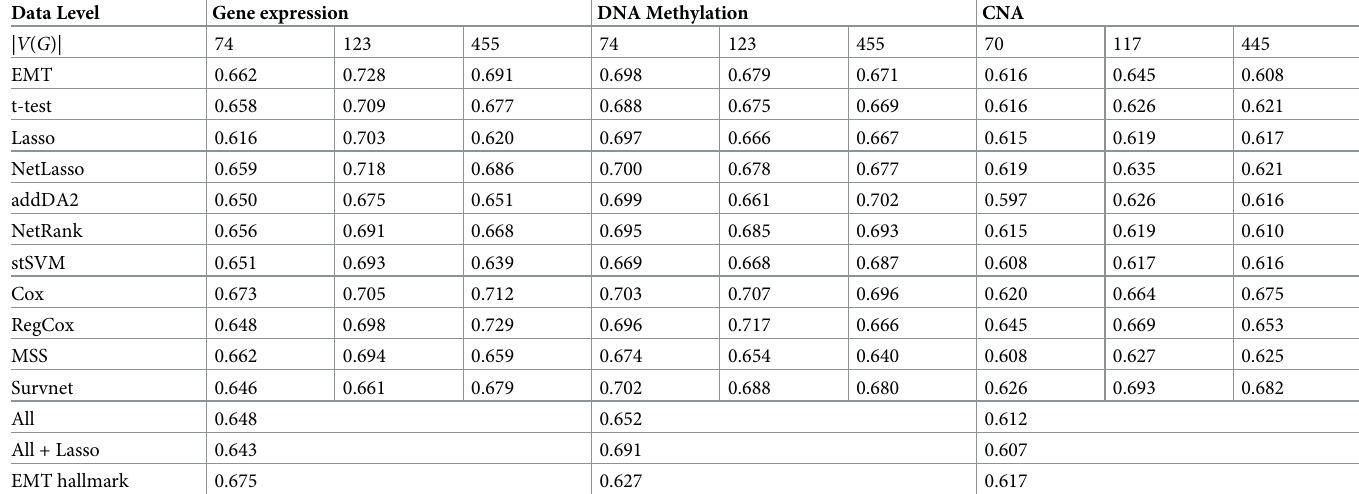
Table 4. The prediction performance of EMT signatures on three data levels. The table gives the average AUC values of EMT signatures on three data levels with each EMT network. The results from comparative groups 2, 3, 4, and 5 are given in the third row and the last three rows. Data Level